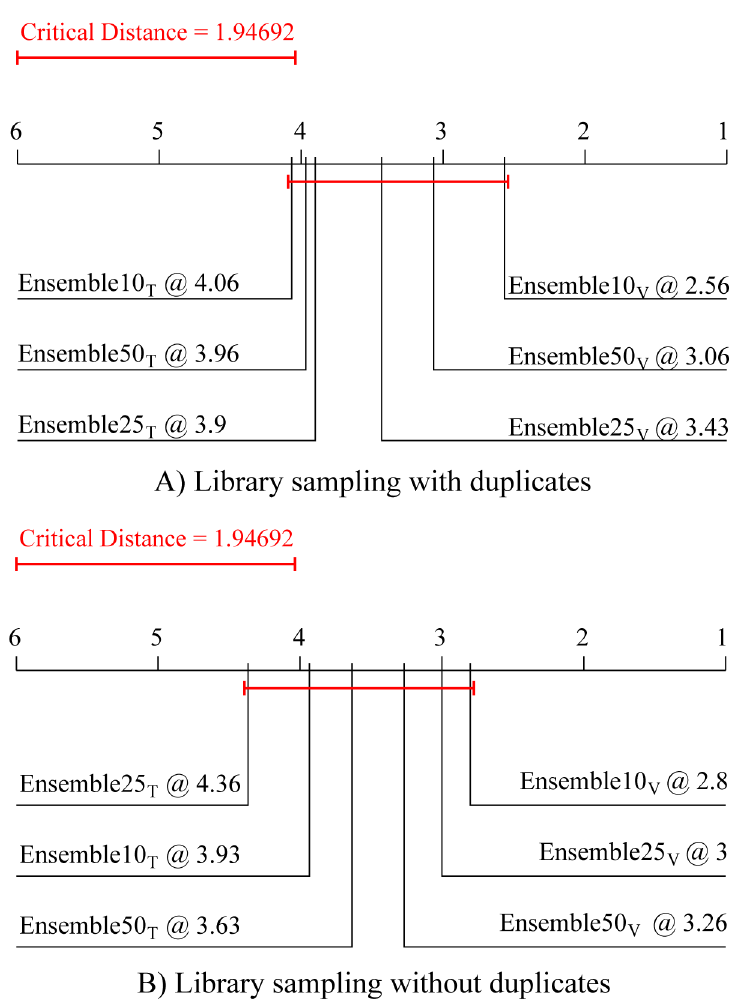
Fig 2. Comparison of the predictive performance in terms of average ranks of the two library sampling methods with different methods for choosing ensemble constituents. Average ranks of ensembles with 10, 25 and 50 constituents combined by averaging and selected differently (based on their train (subscript T) or validation (subscript V) performance). The average ranks refer to the predictive (testing) model performance averaged over the 15 experimental data sets, separately for the case of Library sampling (A) with and (B) without